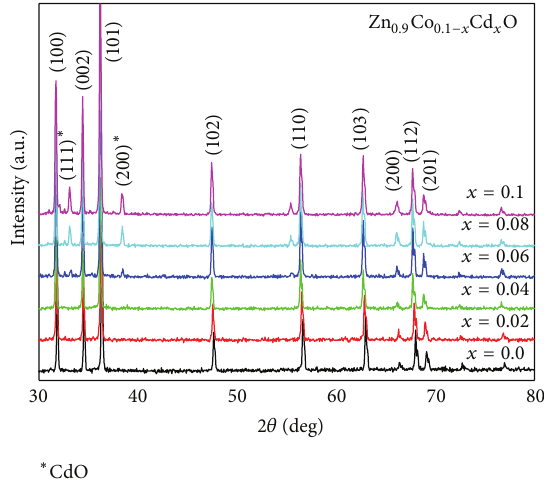
Figure 1: XRD pattern of Zn 0.9 Co 0.1−𝑥 Cd 𝑥 O ( 𝑥 = 0.0, 0.02, 0.04, 0.06, 0.08, and